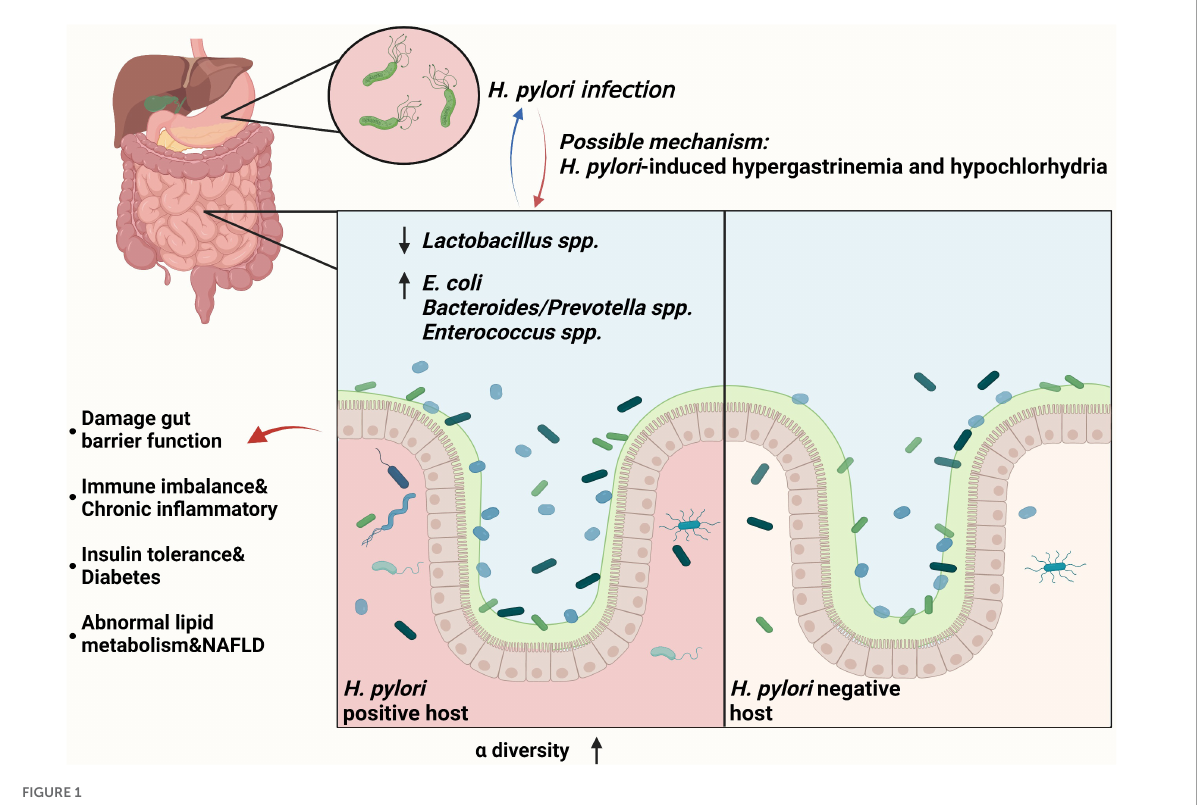
FIGURE1 Helicobacter pylori infection can interact with the gut microbiome and affect extragastric diseases progression. With chronic H. pylori infection, gut microbiome showed a lower level of Lactobacillus spp. and a significant higher loads of E. coli, Bacteroides/Prevotella spp., and Enterococcus spp., increasing α -diversity of gut microbiota (Heimesaat et al., 2014). For the mechanism, gut microbiota changes may be triggered by H. pylori -induced gastric immune pathogenesis, including hypergastrinemia and hypochlorhydria (Lopetuso et al., 2014). Subsequently, low level of beneficial gut bacteria (such as Lactobacillus spp.) may lead to the proliferation of some harmful bacteria and damage gut barrier function (Sanders et al., 2019). This also leads to the immune imbalance and chronic inflammatory, insulin tolerance and diabetes, and abnormal lipid metabolism and NAFLD (He et al.,